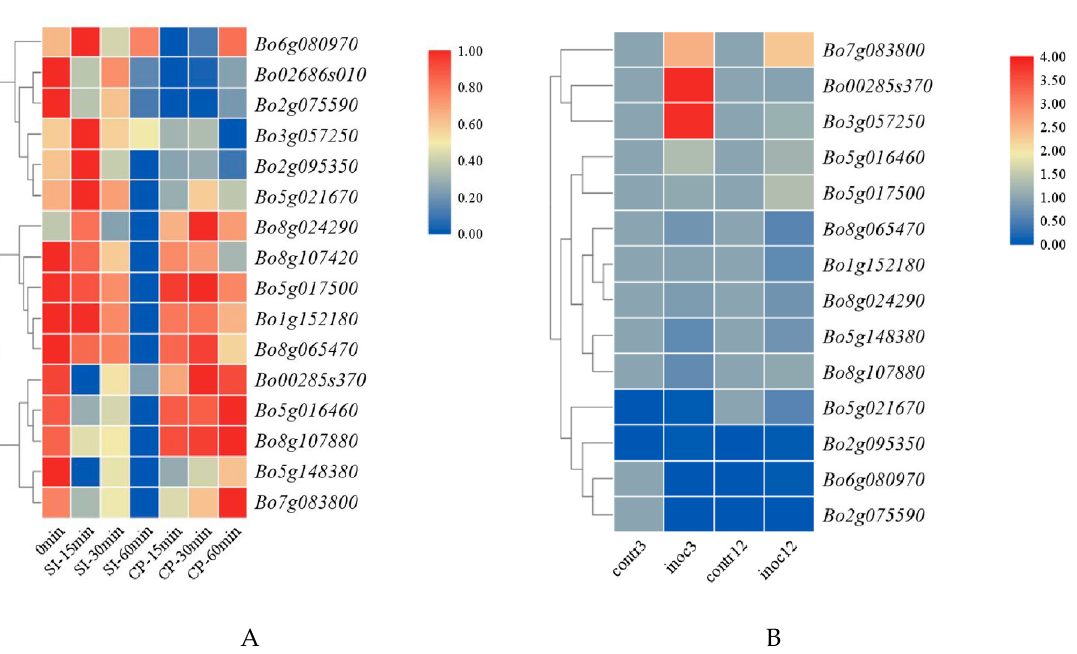
Figure 6. ( A ) Expression patterns of BoGAPDH gene family after self-pollination and cross-pollination. ( B ) The expression pattern of BoGAPDH gene family stimulated by Xanthomonas campestris pv.